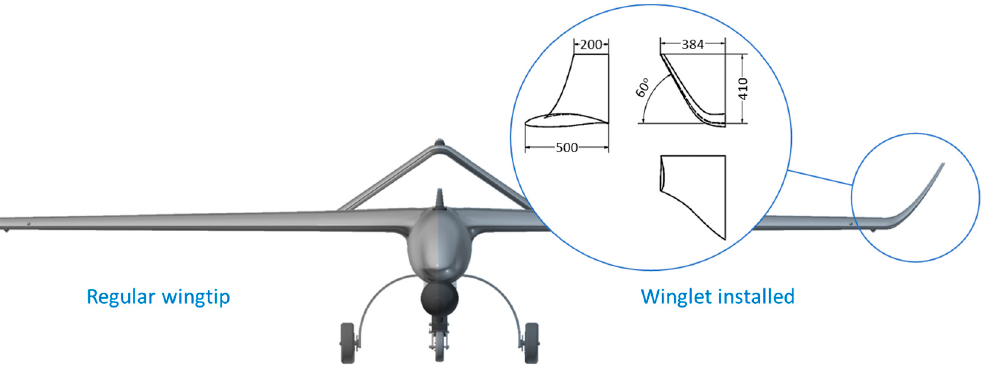
Figure 2. Hellenic Civil Unmanned Air Vehicle (HCUAV) configuration without and with the winglet installed, including the winglet’s characteristics in the detail [7].